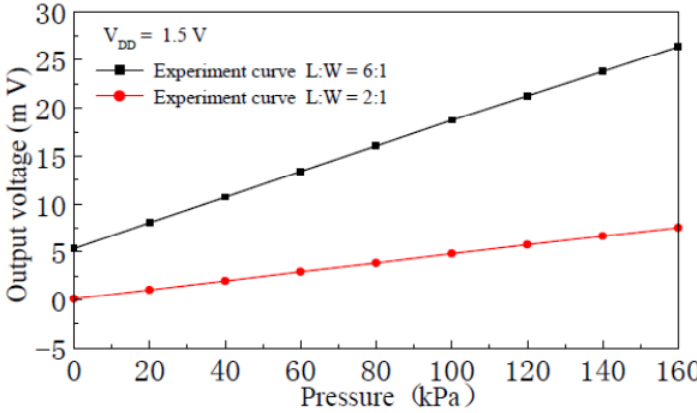
Figure 11. Input-output characteristics experimental curves of the nc-Si/c-Si heterojunction MOSFETs pressure sensor with different channel length-width ratios.